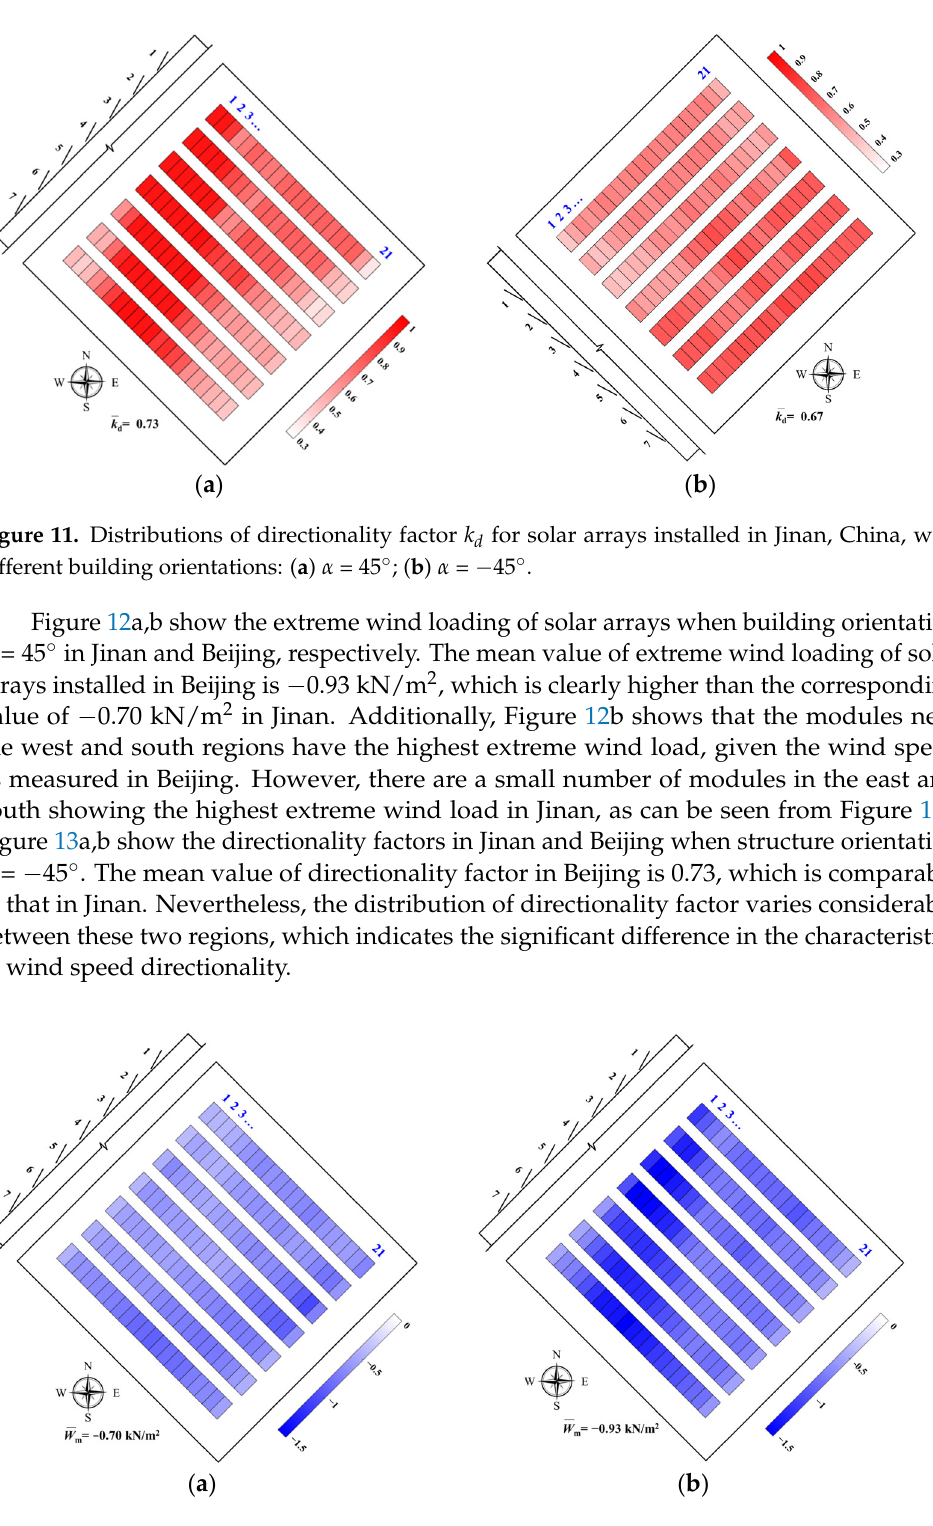
( b ) Figure 13. Distributions of directionality factor k d on solar arrays with building orientation α = 45° at different locations: ( a ) Jinan, China; ( b ) Beijing, China. 3.4. Discussions on Methods for Considering Directionality Effect There are several methods in current wind loading codes and standards that take into account the directionality effect. The directionality factor of 0.85 is proposed in ASCE/SEI 7-16 [10]. In line with the Australian/New Zealand standard [23], it is as- sumed that there is full correlation between different wind direction sectors. The direc- tionality effect is ignored for the claddings and components, as mentioned in the Archi- tectural Institute of Japan (AIJ) recommendations [24]. Figure 14 shows the probability of exceedance for the extreme wind loading applied to Module (2–4) when building orientation α = 0° in Jinan, China. The results, as ob- tained under three different scenarios—by considering the real correlation in line with multiple extreme theory W m , full-correlation assumption W f , and independent assump- tion W i of directional extreme wind speeds—are included. Two dominant wind direc- tions, i.e., NW and E, are identified by comparing the probability of exceedance of ex- treme wind loading in each wind direction. The extreme wind loading is −0.71 kN/m 2 when consideration is given to the real correlation of directional extreme wind speed W m with an MRI of 25 years. The corresponding values determined by full-correlation and independent assumptions, i.e., W f and W i , are −0.62 and −0.72 kN/m 2 , respectively. Ap- parently, the magnitude of extreme wind load determined by multiple extremes W m is